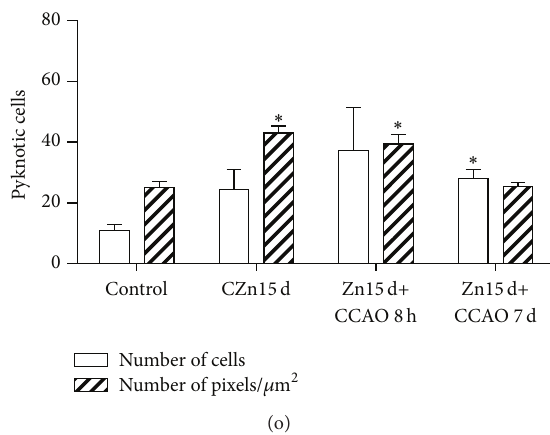
Figure 7: Histopathological evaluation of hippocampus in rats treated with zinc. Paraffin-embedded tissue sections of 3 𝜇 m were stained with hematoxylin and eosin. Control, untreated rat; CZn15d, rats with chronic administration of zinc; Zn15d+CCAO 8 h, rats with chronic administration of zinc before CCAO and evaluations at 8 h after reperfusion; Zn15d+CCAO 7 d, rats with chronic administration of zinc before CCAO and evaluations at 7 days after reperfusion. Dentate gyrus ((a), (d), (g), and (j)), CA1 ((b), (e), (h), and (k)), and CA3 ((c), (f), (i), and (l)) regions of the hippocampus. Apoptotic cells (dark arrow); necrosis (clear arrowhead). (((m), DG), ((n), CA1), and ((o), CA3)) Values of cell counts and color intensity (# pixels/ 𝜇 m 2 ) using ImageJ, Java-based image processing program. ∗ Significant when compared with the control group; unpaired Student’s 𝑡 -test; 𝑃 < 0.05